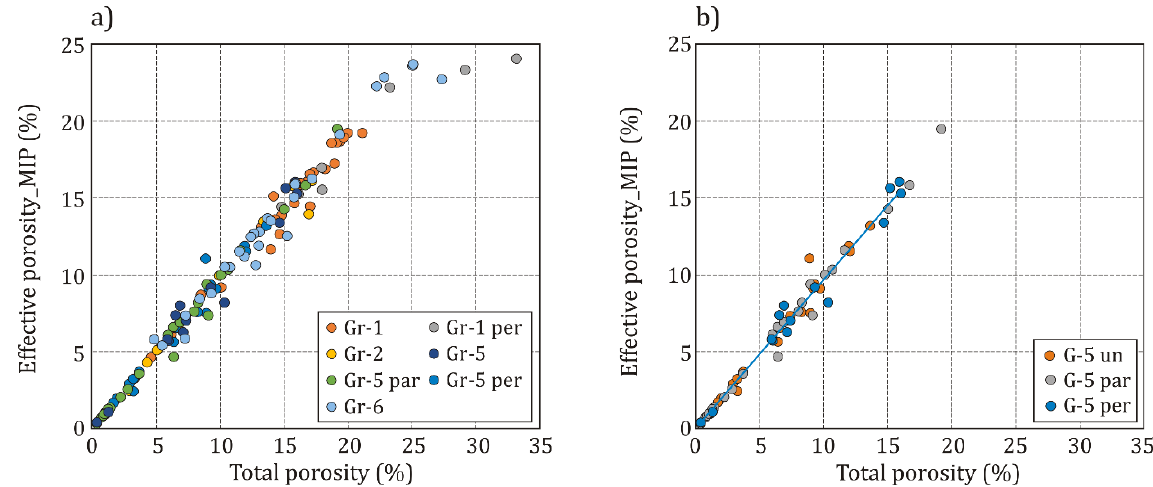
Figure 4. Relationship between effective porosity_MICP vs. total porosity: ( a ) all data; ( b ) data from G-5 borehole; par—parallel; per—perpendicular; un—undescribed cutting of plug.